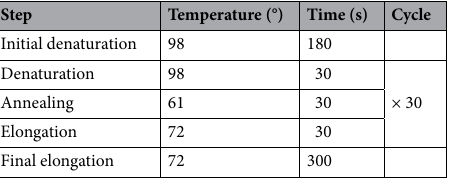
Table 3. RT-PCR program for Tc ace-2 splice variant analysis.